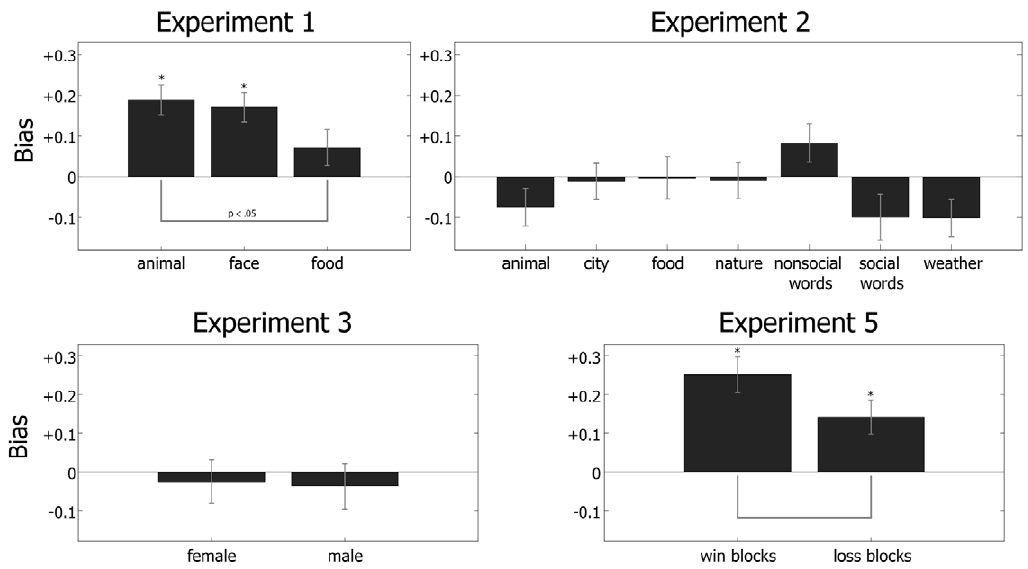
Figure 2. Mean and standard errors across participants of the biases for each condition in Experiments 1, 2, 3 and 5.